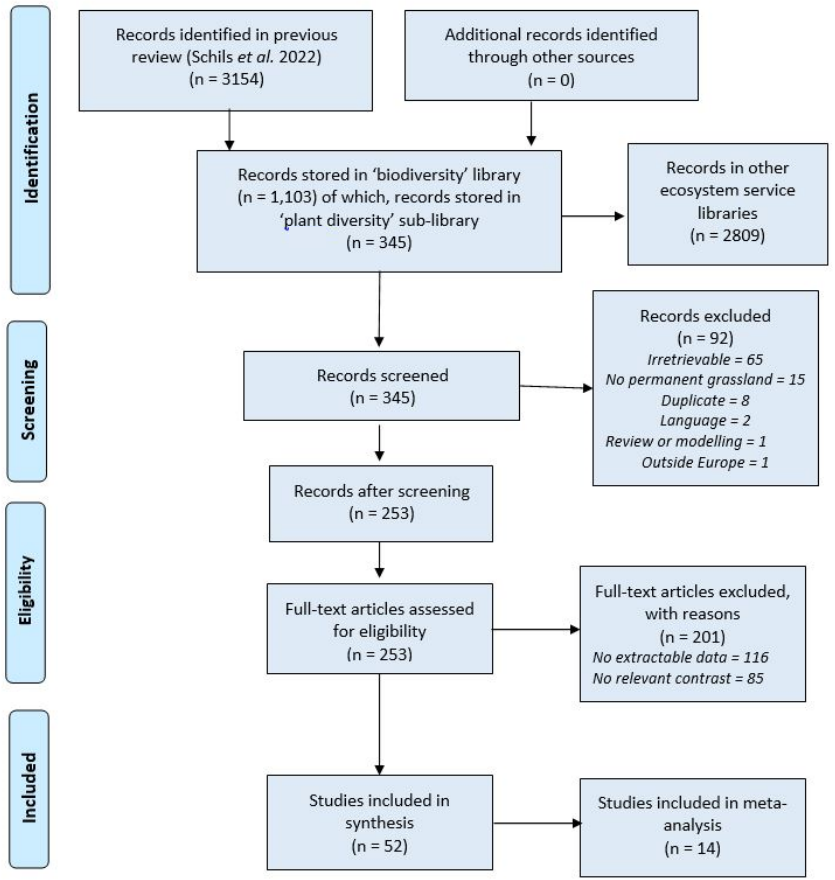
Figure A1. Prisma flow diagram for screening, exclusion and full-text assessment in this study (adapted from [52]).